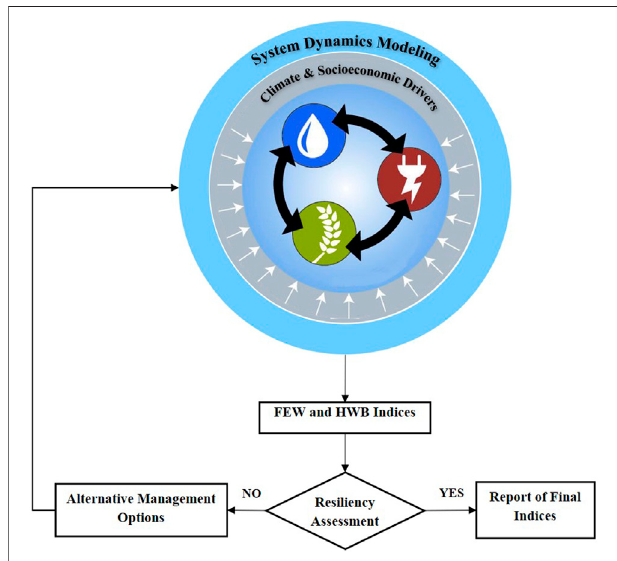
FIGURE 2 | Integrated FEW-WISE framework that couples food – energy – watersystemsanddroughtimpact,socioeconomic,andhuman well-being components.